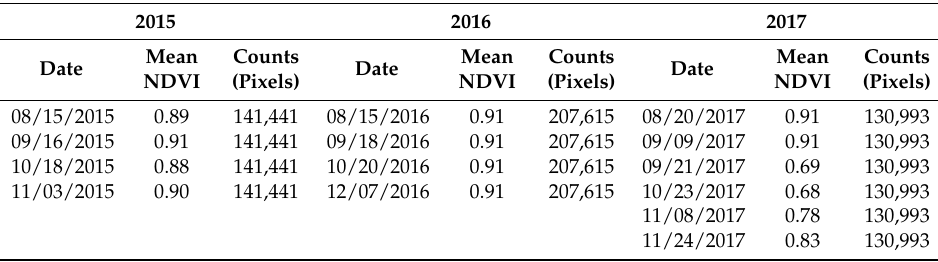
Table 4. The changes in NDVI for Dominica.